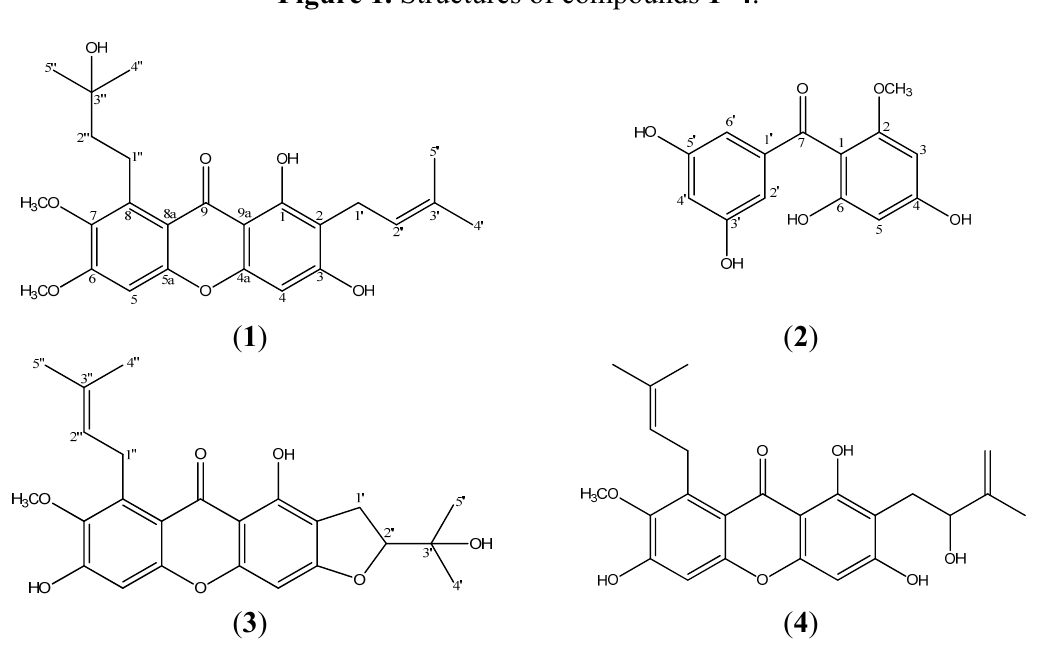
Figure 1. Structures of compounds 1 – 4